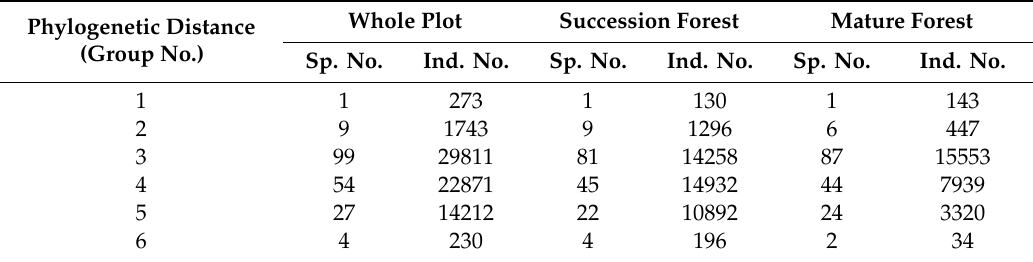
Table 2. Number of species and individuals of trees surrounding the dominant tree Castanopsis chinensis in the 20 ha DHS plot as classified by phylogenetic distance (group) to C . chinensis . Whole Plot Succession Forest Mature Forest Phylogenetic Distance (Group No.) Sp. No. Ind. No. Sp. No. Ind. No. Sp. No. Ind. No. 1 1 273 1 130 1 143 2 9 1743 9 1296 447 99 29811 81 14258 87 15553 4 54 22871 45 14932 44 7939 5 27 14212 22 10892 24 3320 6 4 230 4